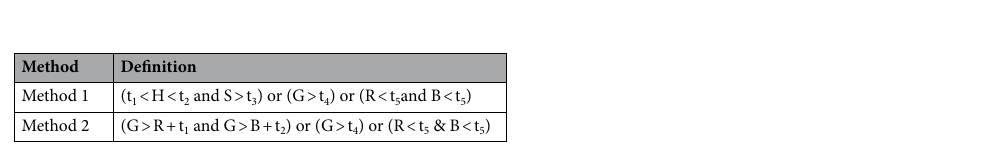
Table 3. The relationship of two threshold classification